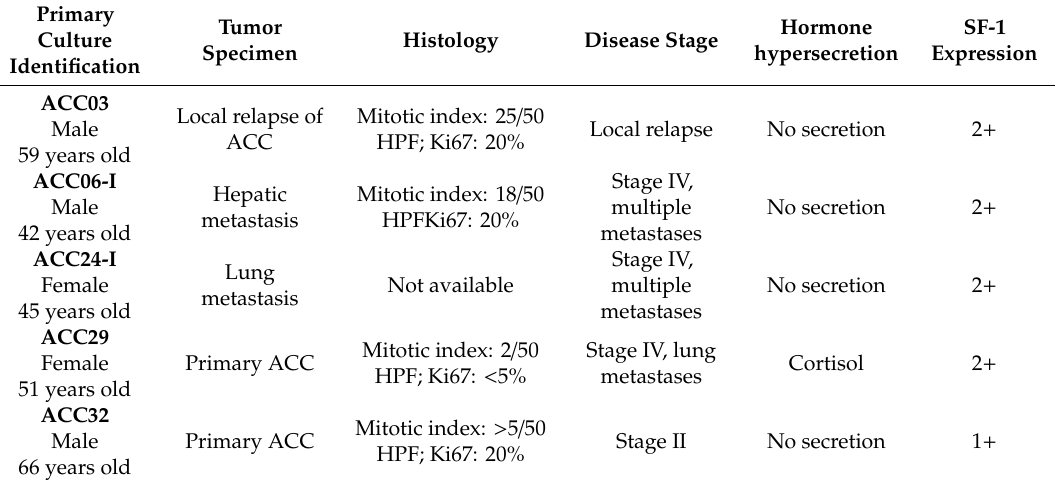
Table 2. Clinical and immunohistochemical characteristics of ACC